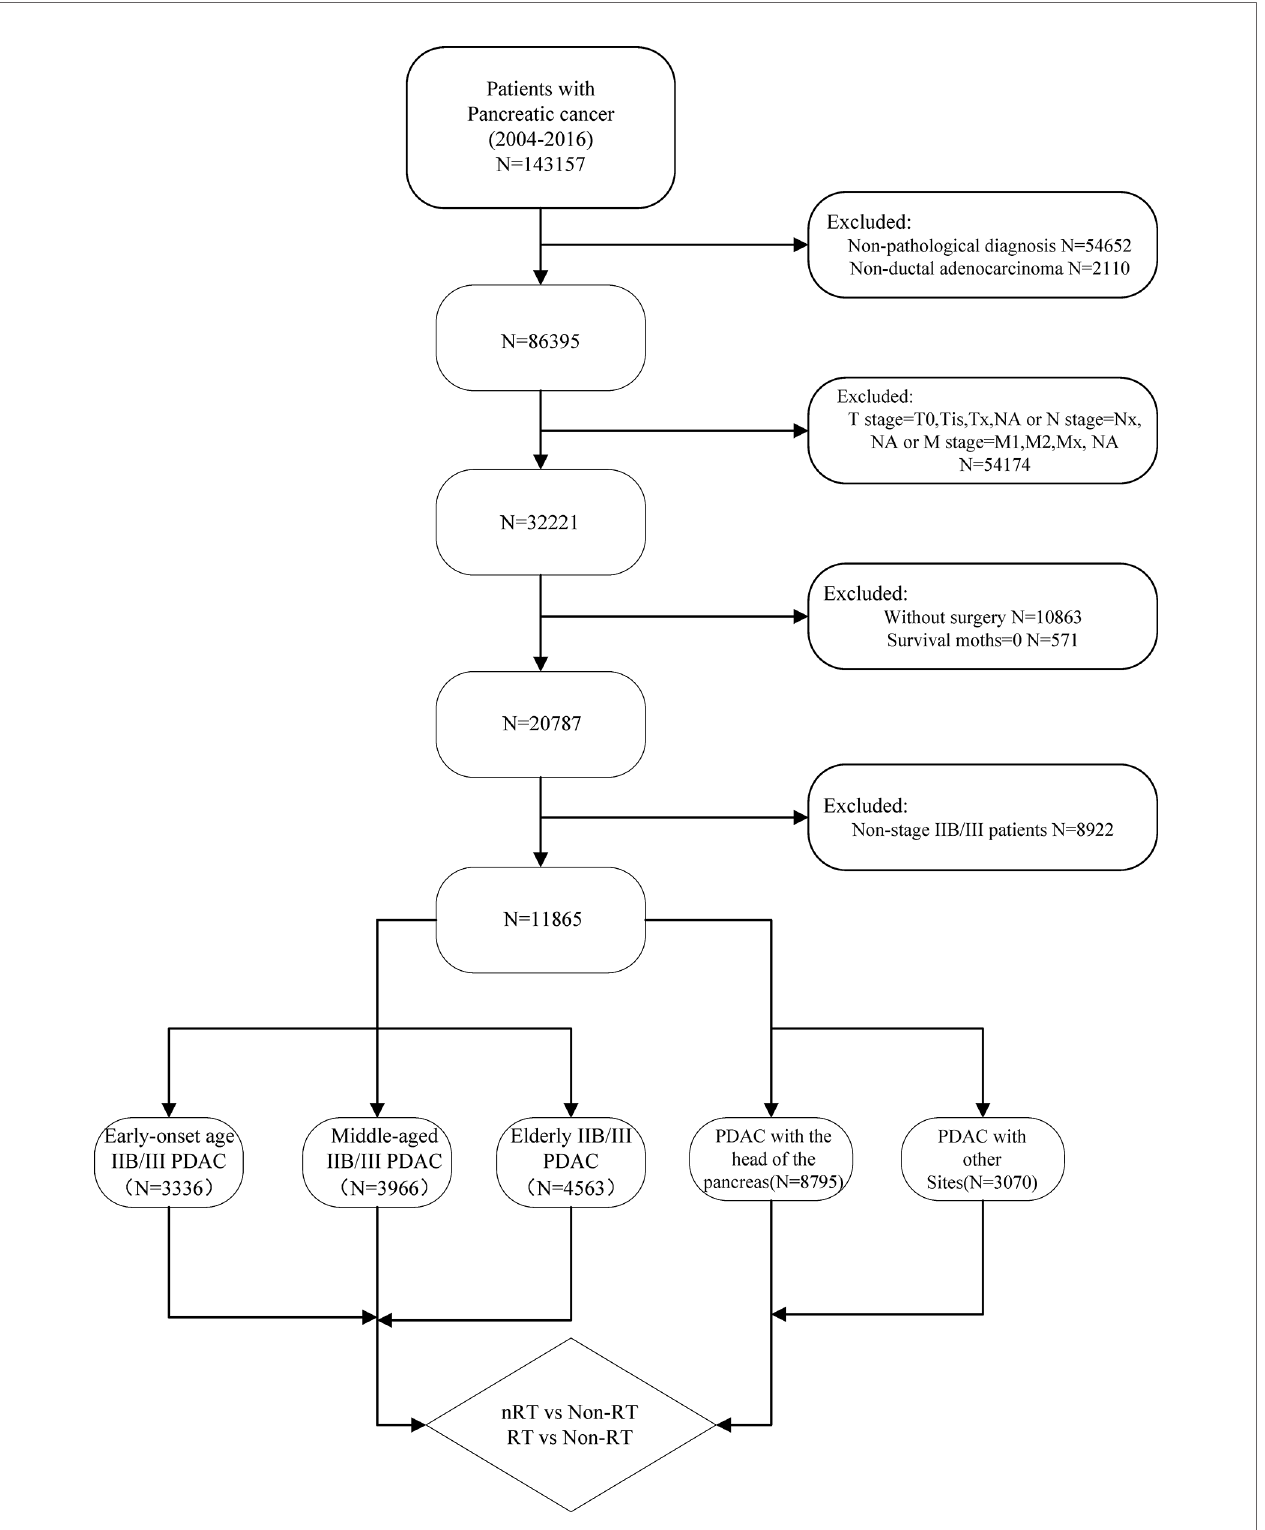
FIGURE 1 | Procedures for inclusion and exclusion of PDAC